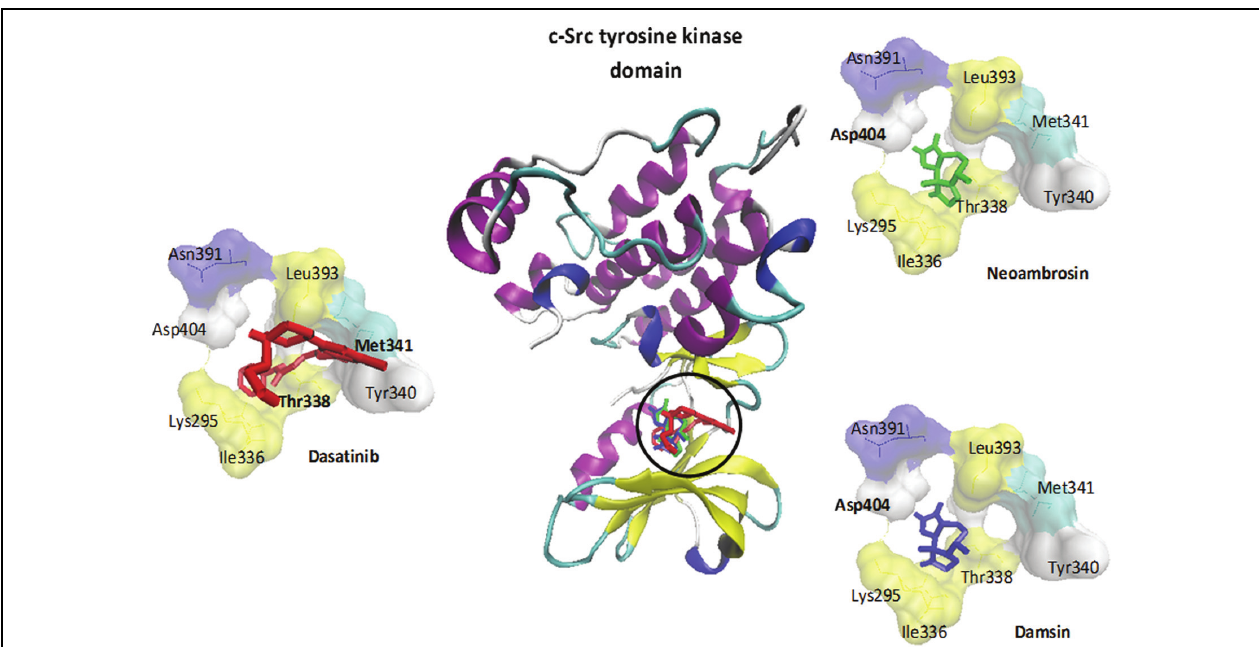
FIGURE 4 | Molecular docking of dasatinib (3), neoambrosin (1), and damsin (2) to the c-Src kinase domain. The protein was represented by its secondary structure in a new carton format, whereas ligands were represented in dynamic bond format with different colors: dasatinib ( 3 ) (red), neoambrosin ( 1 ) (green) and damsin ( 2 ) (blue). Amino acids (AA) involved in H-bonds were shown in a bold font Met341 and Thr338 (dasatinib); Asp404 (neoambrosin and damsin).